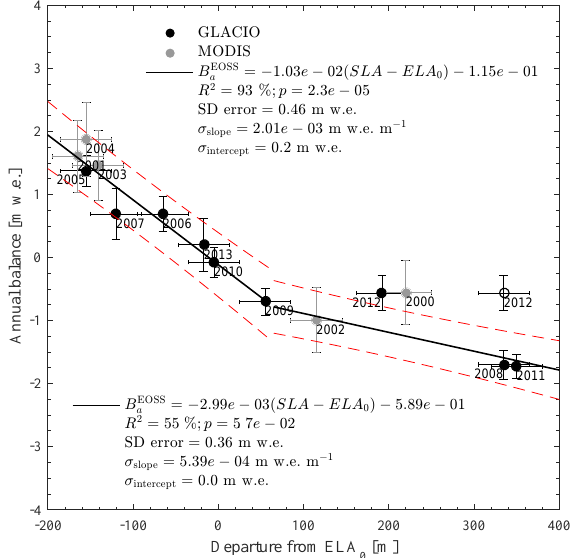
Figure 13. MODIS-derived annual balance vs. EOSS departures from ELA 0 for Brewster Glacier (2000–2013). Note that the 2012 SLA appears twice; the empty point is the original departure esti- mate (335m) while the solid point is that obtained from the rela- tionship with ELA Alps